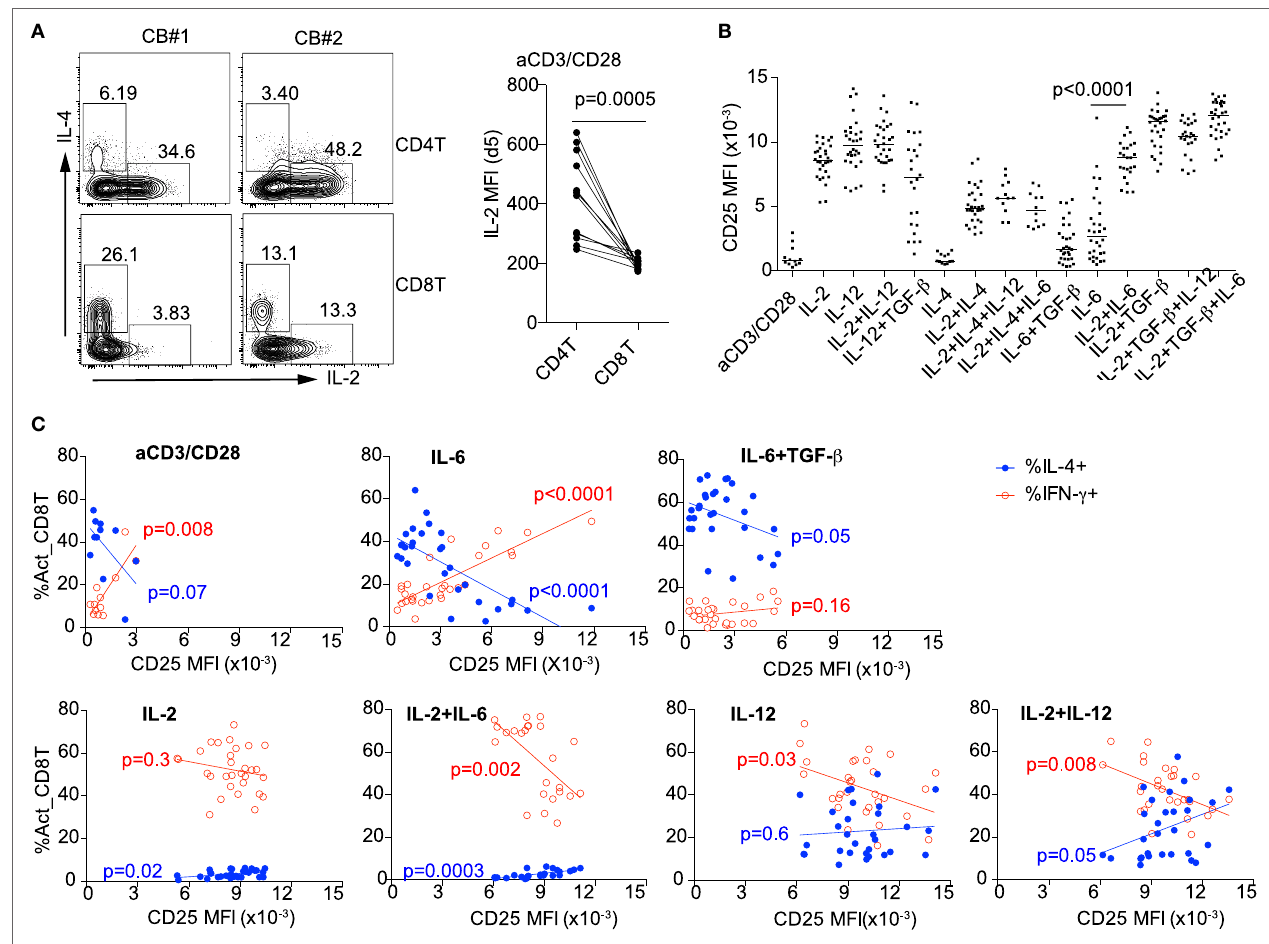
FigUre 4 | CD8 + T cell differentiation is determined by IL-2–IL-2R signaling. (a) Expression of IL-2 in activated CD4 + and CD8 + T cells at day 5. (B) Expression of IL-2 receptor alpha chain CD25 on day 4 after activation of CD8 + T cells in the presence of different cytokines. (c) Under anti-CD3/CD28, IL-6 and IL-6 ± TGF- β T C 2 conditions, decreased expression of CD25 correlates with increased expression of IL-4 (upper panel); under IL-2 + IL-6, IL-12, IL-2 + IL-12 T C 1 conditions, decreased expression of CD25 correlates with increased expression of IFN- γ (lower